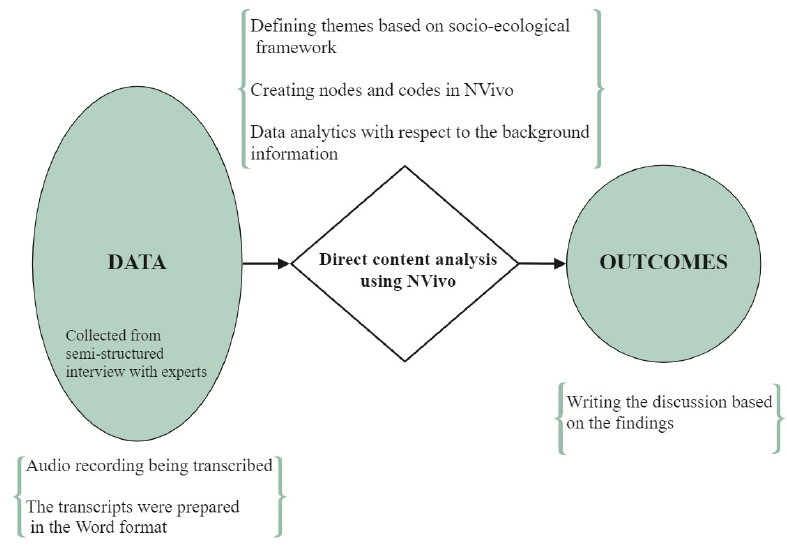
Figure 3. Direct content analysis method using NVivo. Authors. Table 2. Open-ended questions designed for the